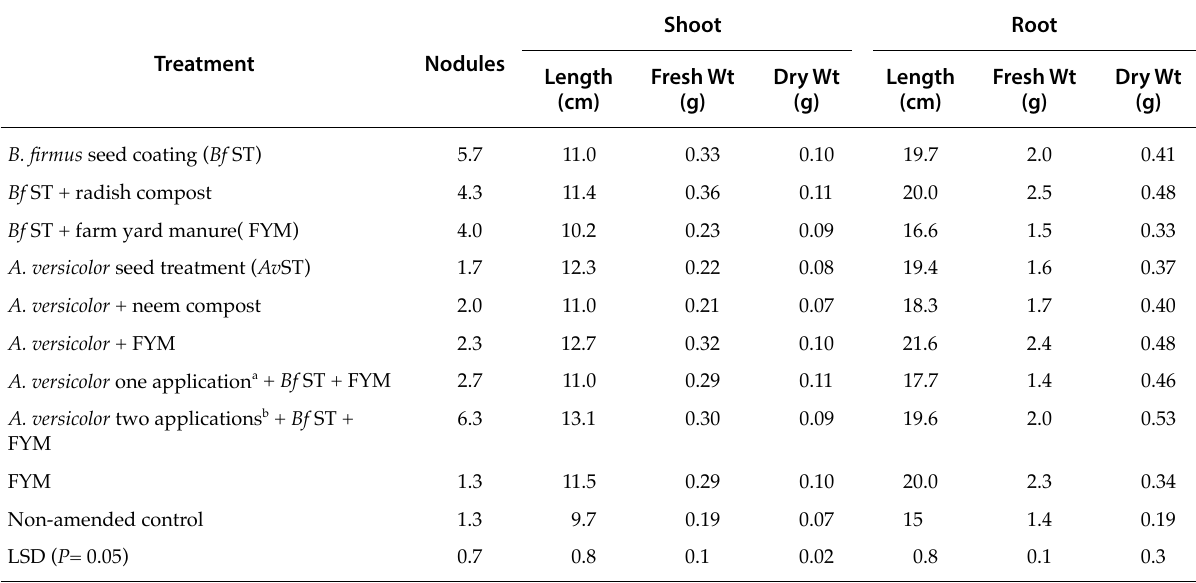
Table 2. Mean plant parameters for 20 d old cowpea plants from plots treated in 2006 with the biocontrol agents Bacillus firmus and Aspergillus versicolor and soil